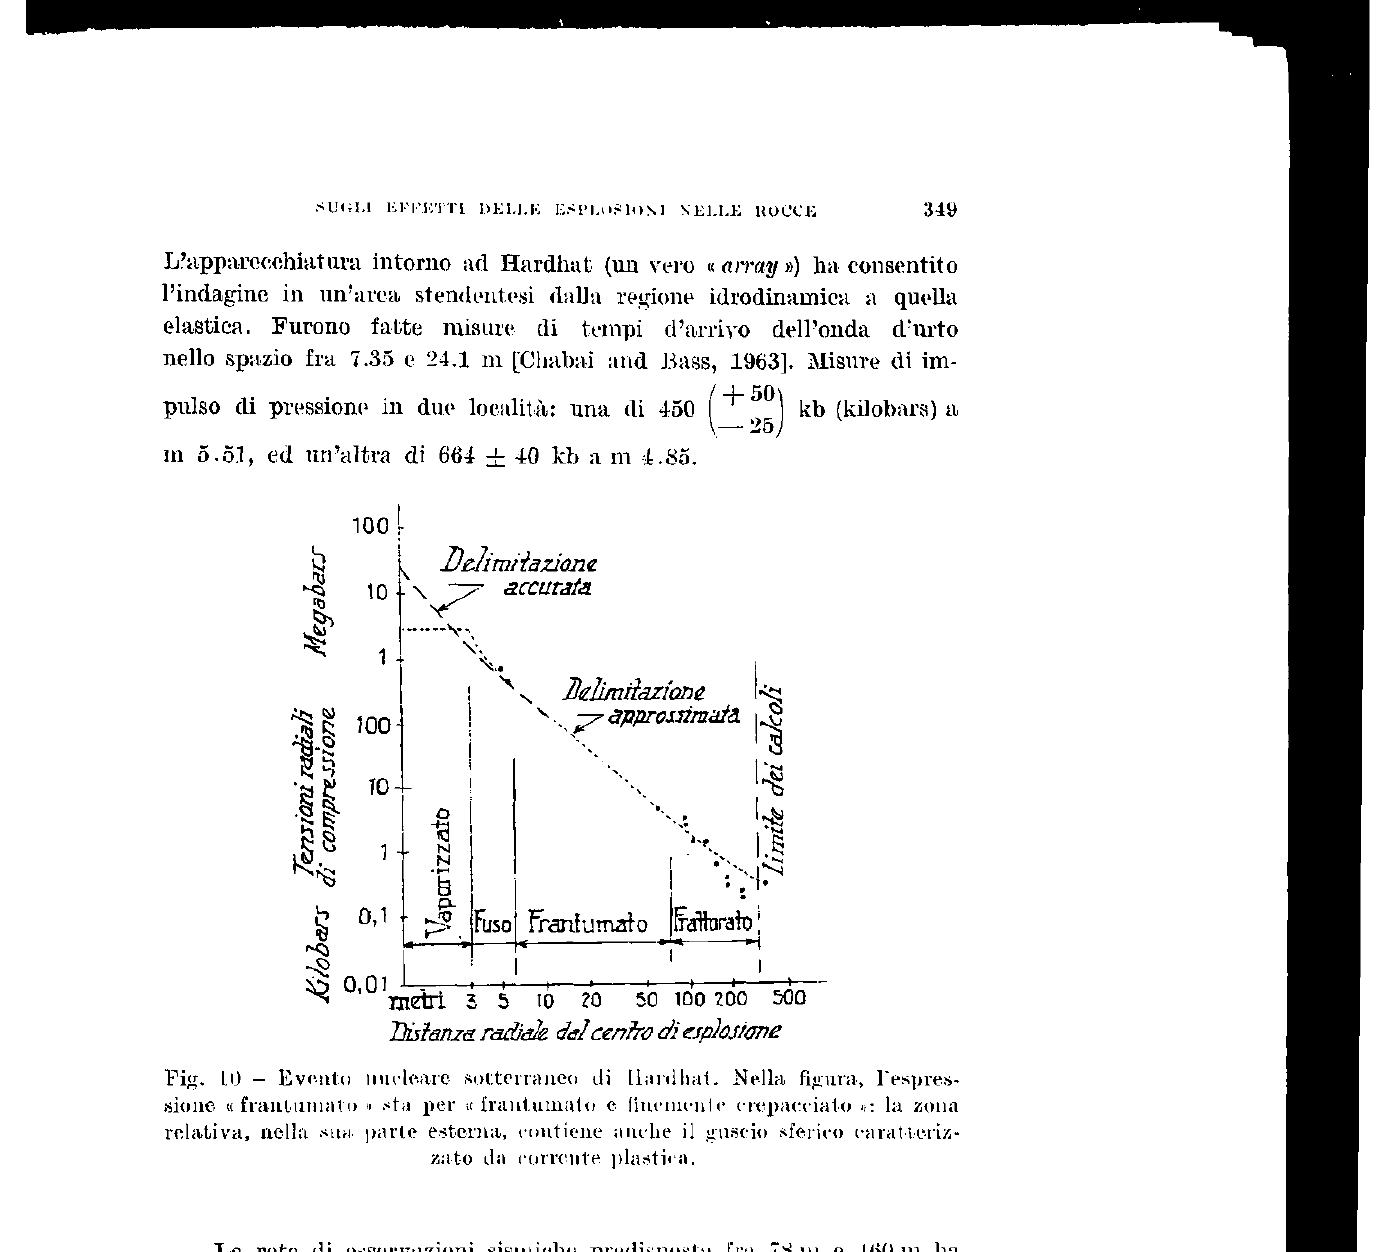
Fig. 10 - Evento nucleare sotterraneo eli Hanlhat. Nella figura, l'espres- sione « frantumato » sta per « frantumato e finemente crepaeciato »: la zona relativa, nella sua parte esterna, contiene anche il guscio sferico caratteriz- zato da corrente